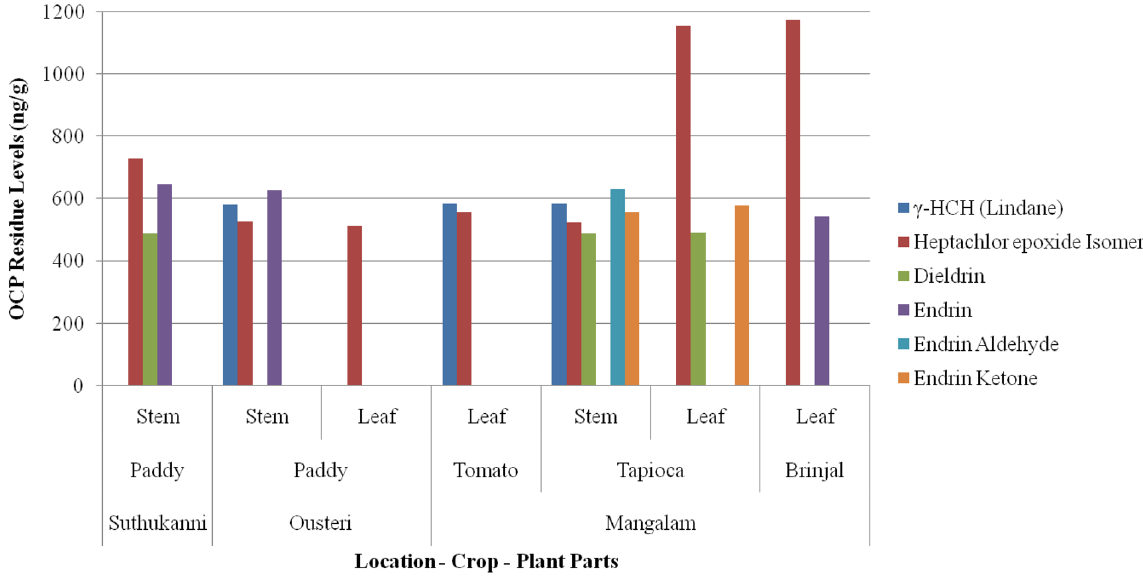
Figure 2. OCP residue levels in different plant